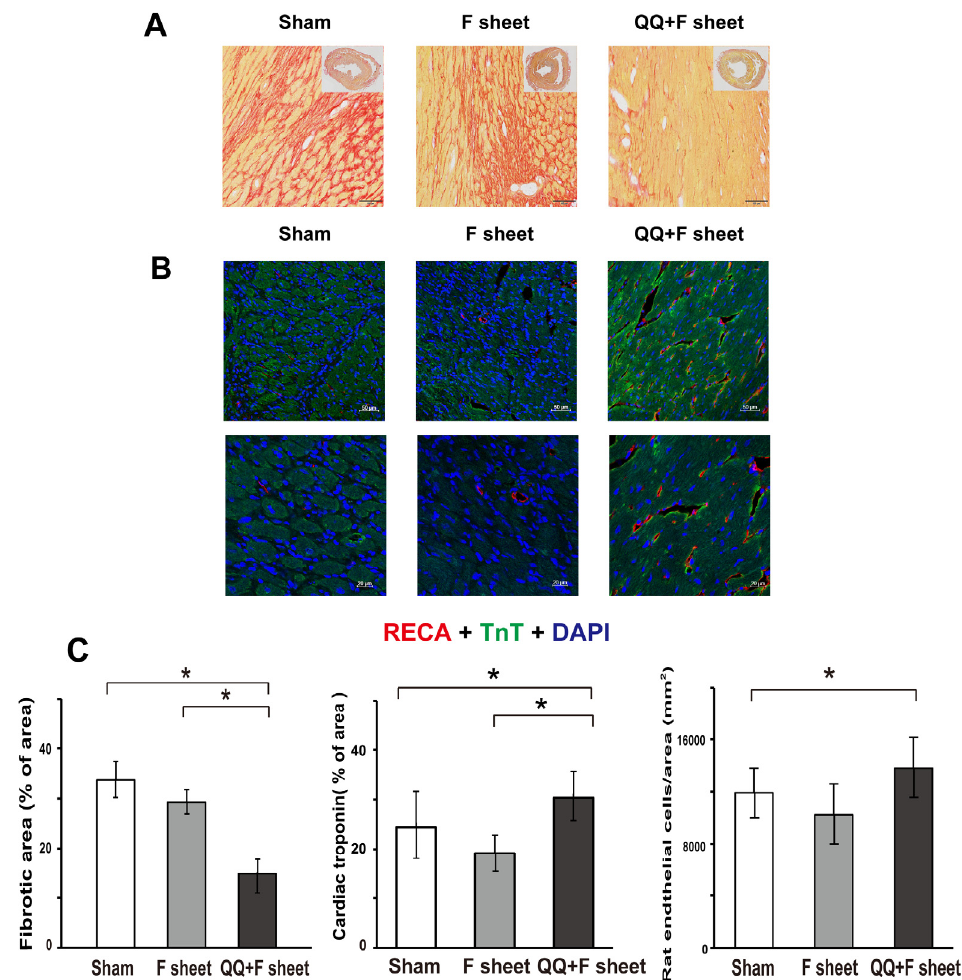
Figure 8. The effect of QQ+F sheets transplantation on left ventricular (LV) remodeling in the hearts of EAM rats. Heart tissues were harvested 14 days after cell sheet transplantation and markers for LV remodeling were detected using histological analysis, as described in Methods. The QQ+F sheet transplant group showed significantly reduced heart fibrosis. ( A ) Representative heart sections stained with picrosirius red ( × 2 and × 100) at 14 days after sheet transplantation. To evaluate fibrotic area, the heart tissue sections were treated with picrosirius red stain. The percentage of fibrotic area was determined using ImageJ software, and the threshold color plugin set to red fibrotic tissue was selected and converted to a binary image. Scale bar = 100 µ m. ( B ) Representative heart sections were stained with immunofluorescence RECA-1( × 20; Scale bar = 50 µ m, × 40; Scale bar = 20 µ m) at 14 days after sheet transplantation. RECA (red): anti-endothelial cell antibody (RECA-1), TnT (green): anti-cardiac troponin T antibody, DAPI (blue). ( C ) The average collagen deposition of three heart sections (cardiac base, papillary muscle, and apex) showed a significant decrease in the QQ+F sheet group compared with that in the sham and F-sheet groups ( p < 0.05). Number of RECA1-positive blood vessels per mm 2 . The total blood vessel counts of three heart sections showed an increase in the QQ+F sheet group compared with that in the F-sheet group ( p < 0.05). The average cardiac